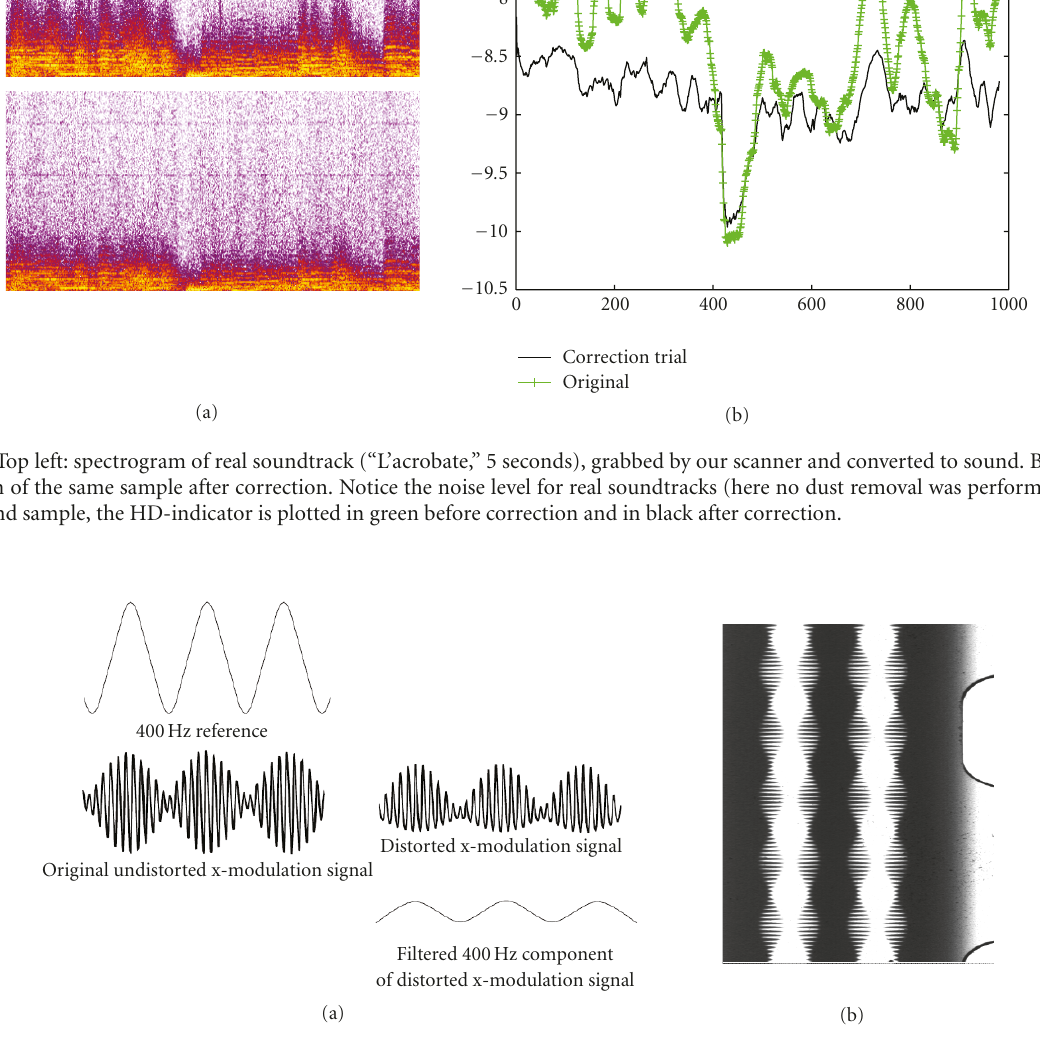
Figure 25: (a): graphical illustration of the cross-modulation test (lifted from Kodak’s technical note “cross-modulation distortion testing for the motion picture laboratory”). (b): image grabbed from a real cross-modulation test reel (stereo